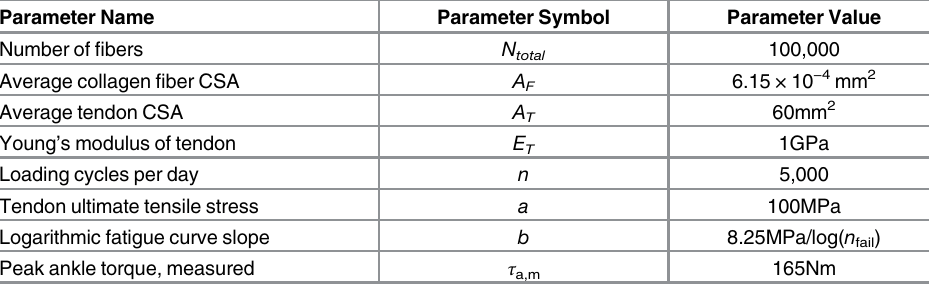
Table 1. Parameter names, symbols and values.